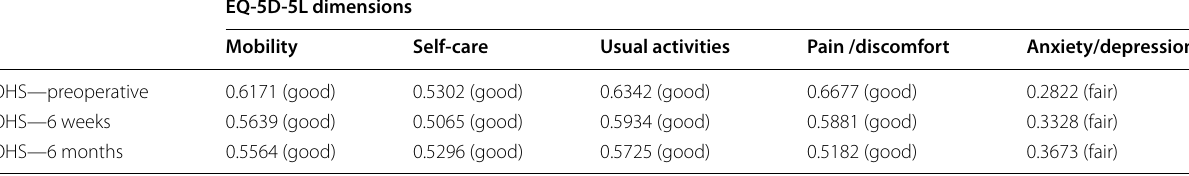
Table 3 OHS as compared to EQ‑5D‑5L dimensional components over time (Spearman’s